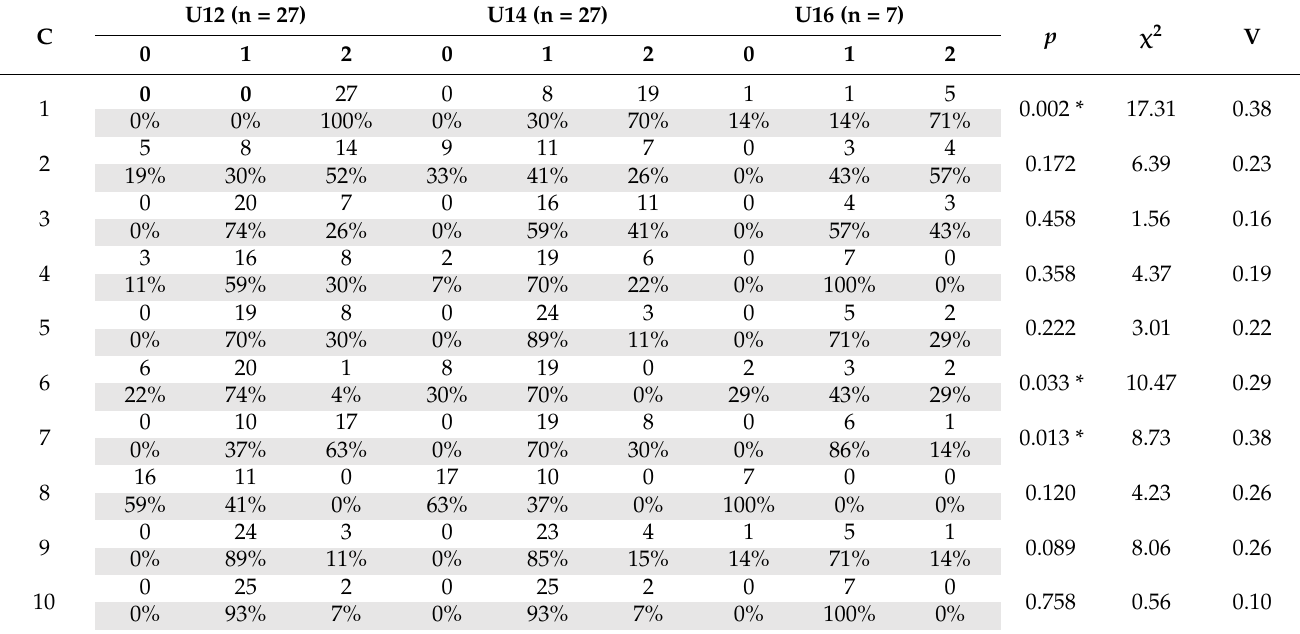
Table 5. Number of participants who scored for each scoring criterion and the percentage (%). Descriptive values obtained, classified according to age.